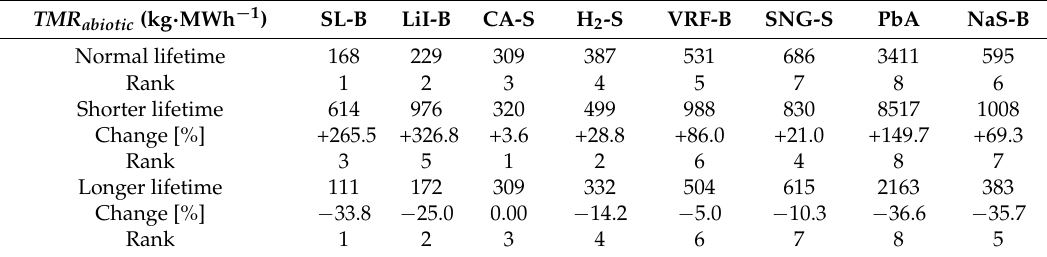
Table A3. Ranking of electrical energy storage technologies for TMR abiotic with normal, shorter and longer lifetime.